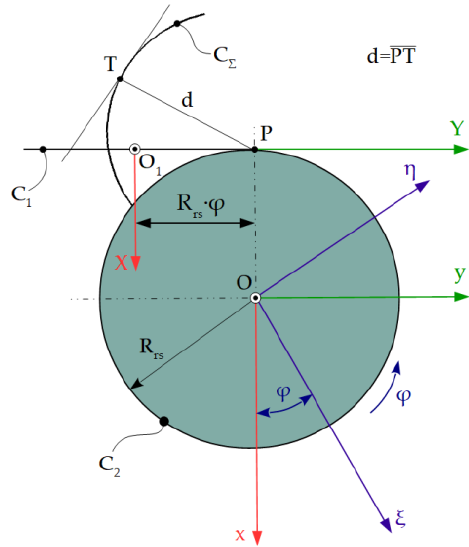
Figure 11. The minimum distance method applied at generating with rotary cutter tool [2]. To ensure the generation of the active surface of the pump screw [62,63], it is nec- essary that the two helical surfaces, the tool and the blank, have opposite directions and have the same inclination to their own axes on the rolling circles.